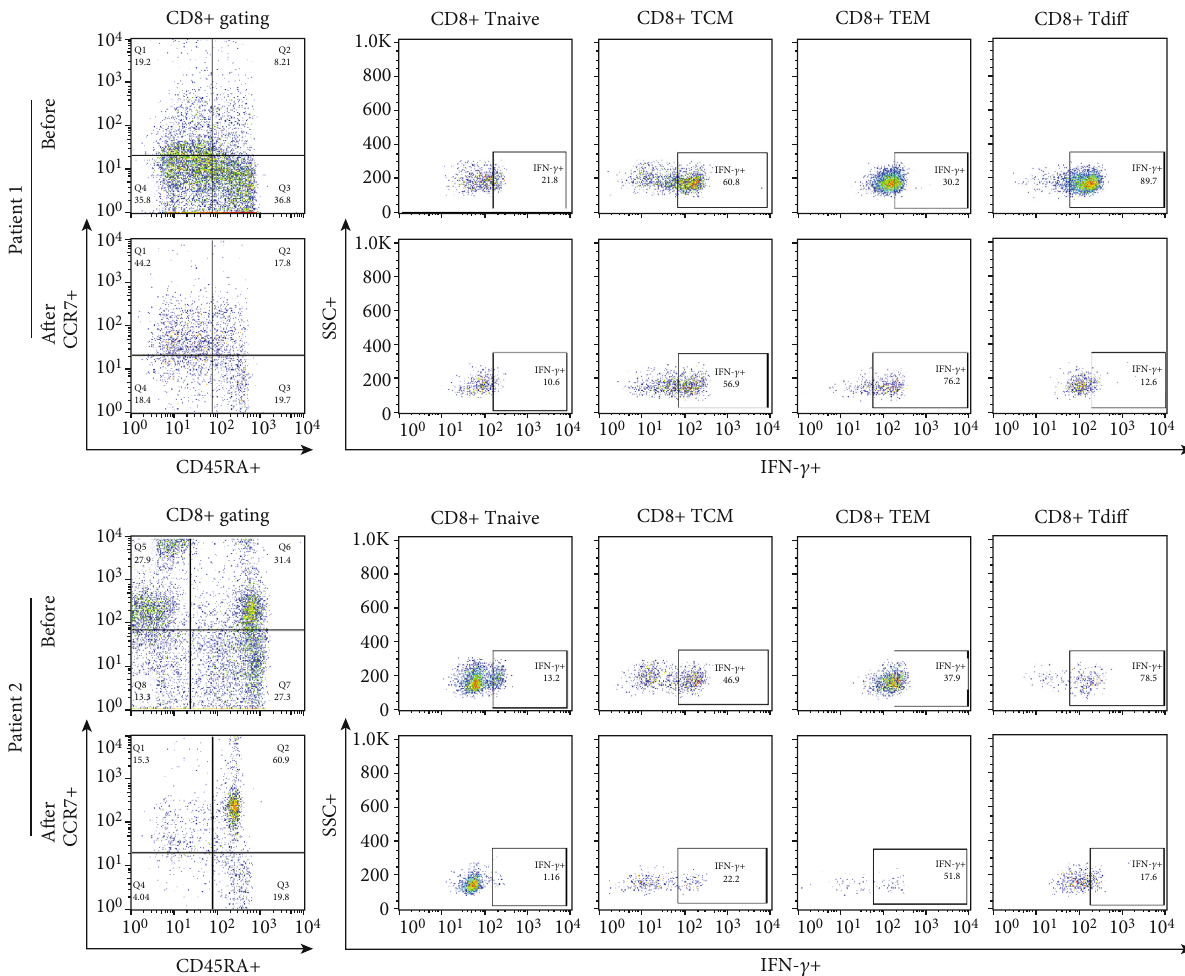
Figure 4: Comparison of CD8+ T cell subsets before and after MSC treatment. PBMCs were stained with anti-CD8 APC-conjugated, anti- CD45RA ± FITC-conjugated, anti-CCR7 APC-conjugated, and anti-IFN- γ antibodies. CD8+ T cells were gated for further analysis. The proportions (%) of CD8+ T cells/lymphocytes, CD8+ Tnaive (CD45RA +CCR7+/CD8+ T cells), CD8+ TCM (CD45RA-CCR7+/CD8+ T cells), CD8+ TEM (CD45RA-CCR7-/CD8+ T cells), and CD8+ Tdi ff (CD45RA+CCR7-/CD8+ T cells) in each patient were determined. After surface staining with anti-CD8 APC-conjugated, anti-CD45RA ± FITC-conjugated, and anti-CCR7 APC-conjugated antibodies, analysis of IFN- γ expression in CD8+ T cell subsets by intracellular fl ow cytometry was performed. The proportions (%) of IFN- γ +/CD8+ Tnaive (CD45RA+CCR7+/CD8+ T cells), IFN- γ +/CD8+ TCM (CD45RA-CCR7+/CD8+ T cells), IFN- γ +/CD8+ TEM (CD45RA-CCR7- /CD8+ T cells), and IFN- γ +/CD8+ Tdi ff (CD45RA+CCR7-/CD8+ T cells) in each patient were determined. “ Before ” indicates the results at the start of MSC treatment, and “ After ” indicates the results at 3 months after the fi nal MSC infusion. MSCs: mesenchymal stem cells; PBMCs: peripheral blood mononuclear